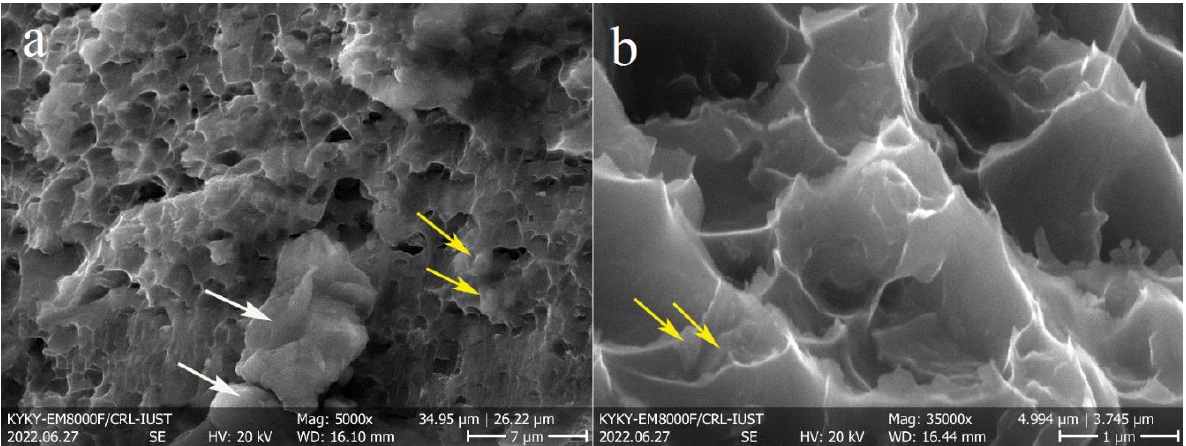
Figure 13 . Secondary electron SEM images of fractured surfaces: ( a ) S2, showing the presence of large Si particles, and ( b ) S3, revealing the existence of fine Si particles on the dimple walls.